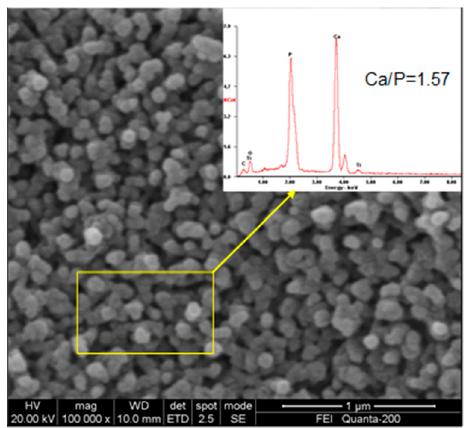
Figure 5. SEM image of an HA coating on TiO 2 nanotubes; the insert refers to EDS microanalysis of the HA coating.